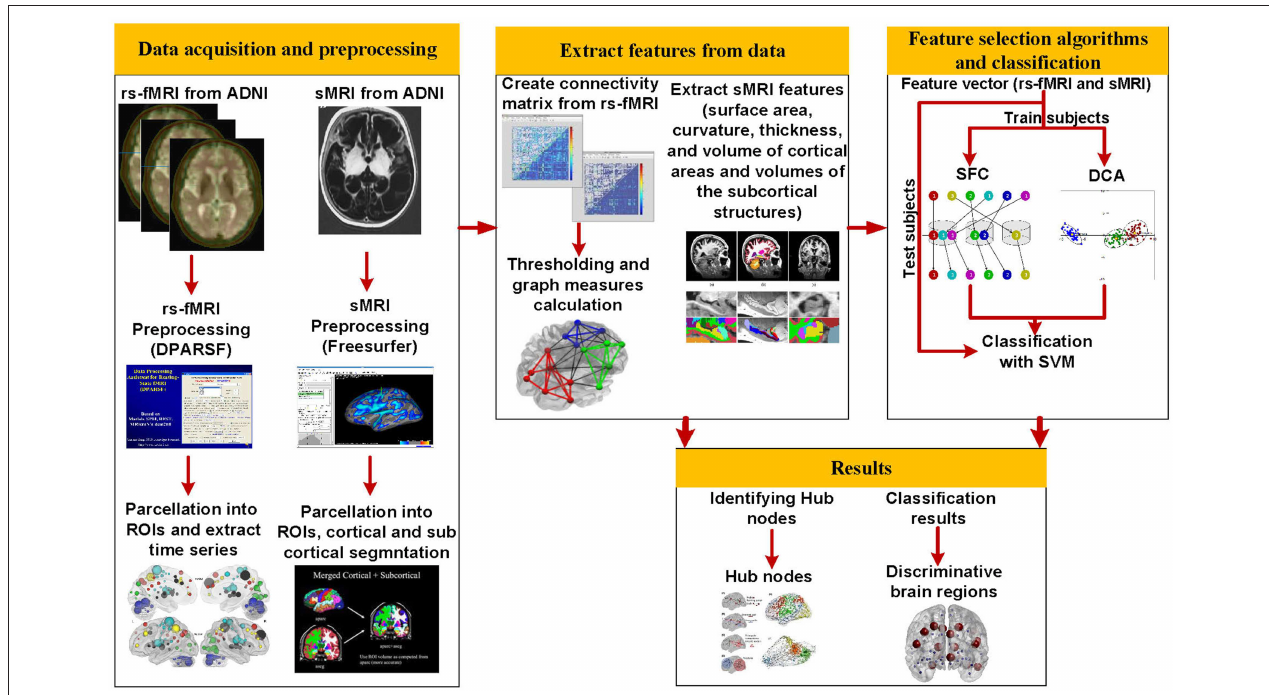
FIGURE 1 | The overall procedures of this